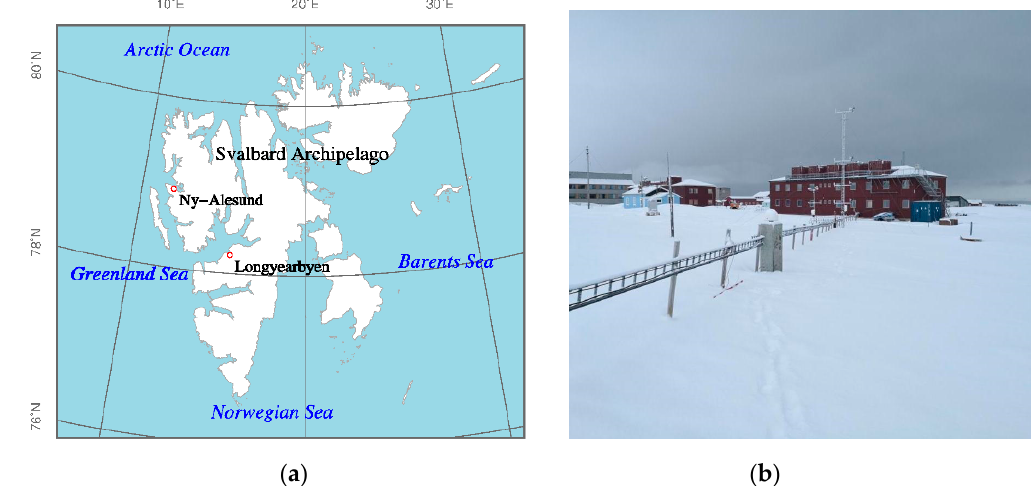
Figure 1. ( a ) Map of location of Ny-Alesund in Svalbard. ( b ) Picture of local environment surrounding GNSS station, photographed by the authors in field work in 2018.